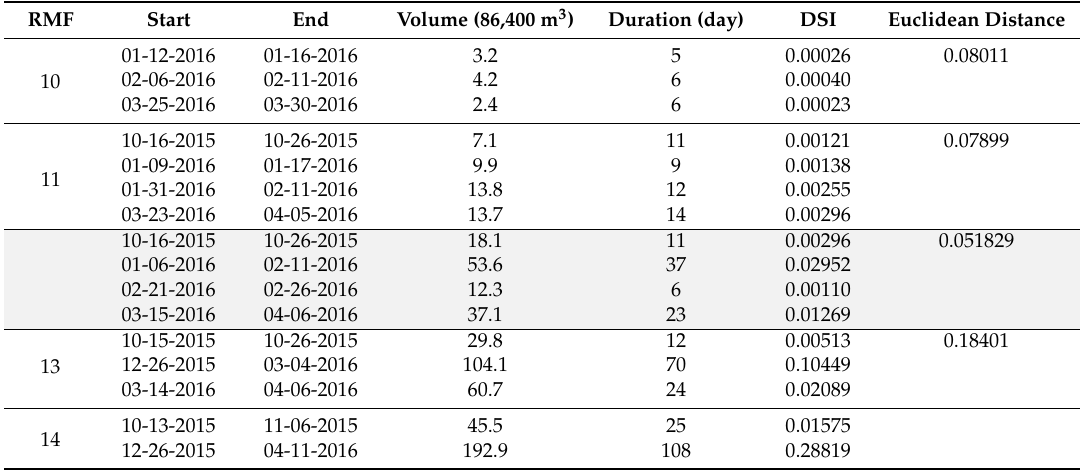
Table 7. Streamflow deficit events and their severity indexes for Bugang (2012–2016, non-irrigation period). RMF